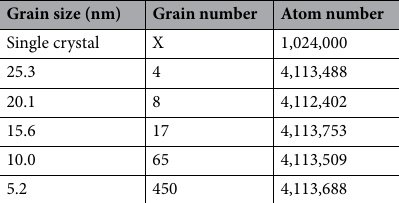
Table 4. The models of single crystal and polycrystalline Nb 20.6 Mo 21.7 Ta 15.6 W 21.1 V 21.0 RHEAs for the heating